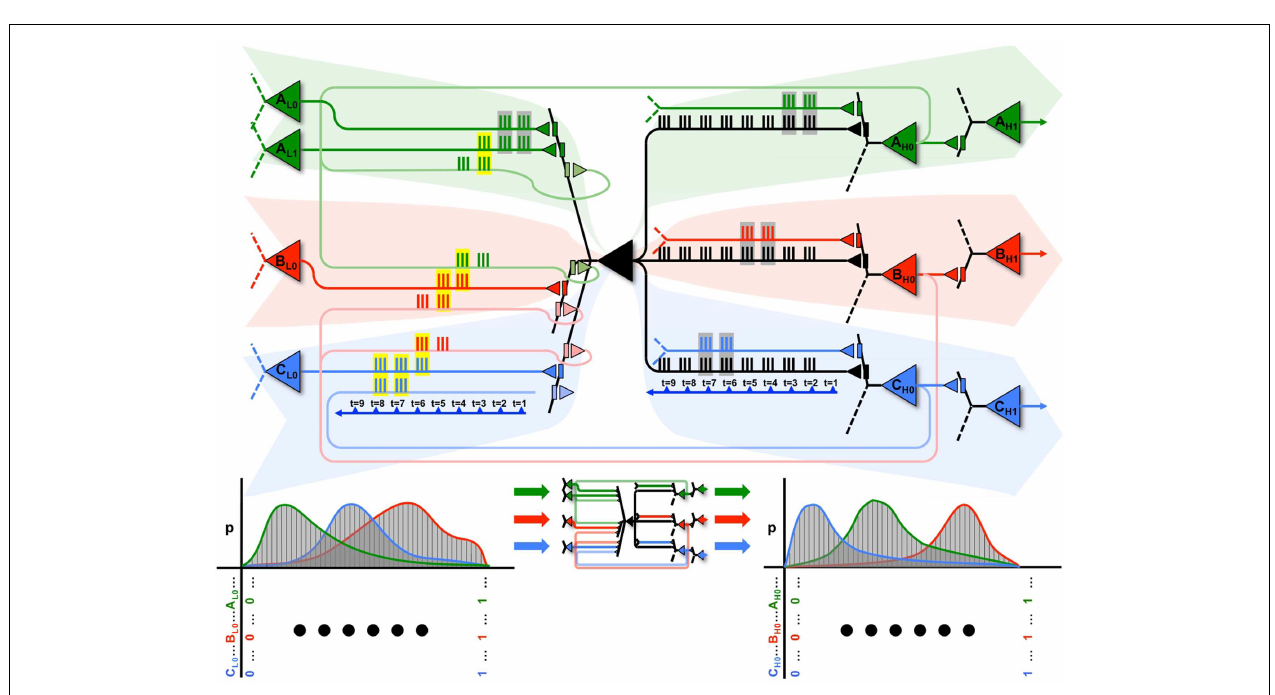
coincident spiking events that cause plastic changes (i.e., both feedforward and feedback spikes) are surrounded by yellow boxes. Bottom: the black neuron may have different cause repertoires when participating with different cliques, as shown by the different red, green, and blue cause repertoires.